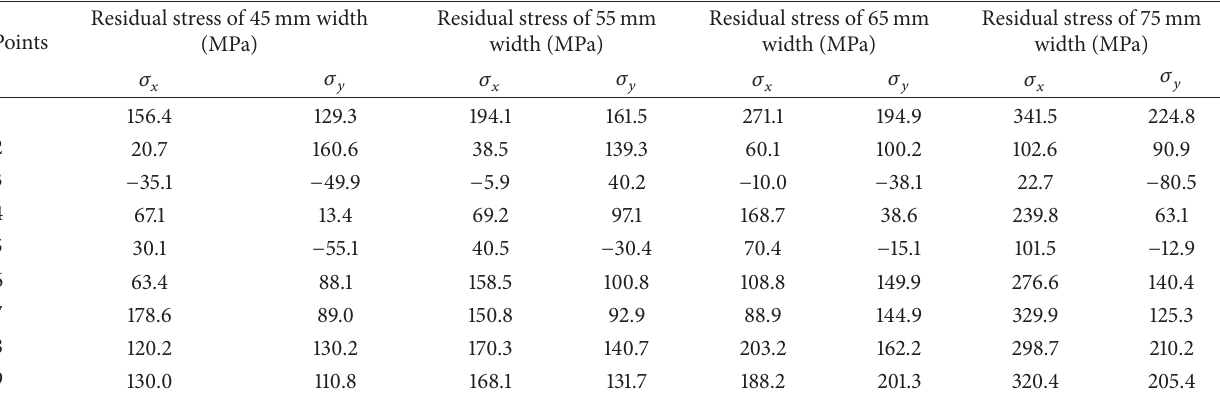
Table 2: Results of the measured residual